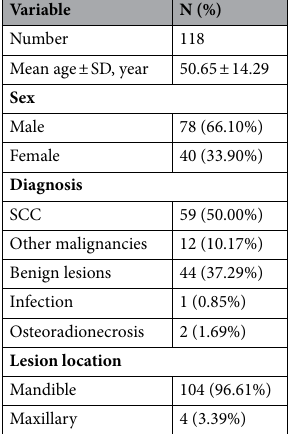
Protocol for the analysis of measurements. In order to investigate optimal fibula segments fibula suitable for mandibular reconstruction, we compare the height and widths at the selected planes of fibula and mandible in each patient. The ratio of height was calculated as the height at Side D, Side M and Side P of fibula/ the height at anterior, premolar and molar areas of mandible, expressed as H (plane/area). Similarly, the ratio of width was calculated as the W1 or W2 at Side D, Side M and Side P of fibula/ the W1 or W2 at anterior, premolar and molar areas of mandible, expressed as W1 (plane/area) and W2 (plane /area). The closer the value is to 1, the higher the morphological similarity is. Statistical analysis. Data are expressed as the mean ± SD (standard deviation, SD) and statistically ana- lyzed with SPSS 23.0 software (SPSS Inc, IL). The difference among three groups was evaluated using a one-way analysis of variance with a Tukey post hoc test and the two groups were compared using a Wilcoxon matched pairs test. Statistical significance was set at p < 0.05.